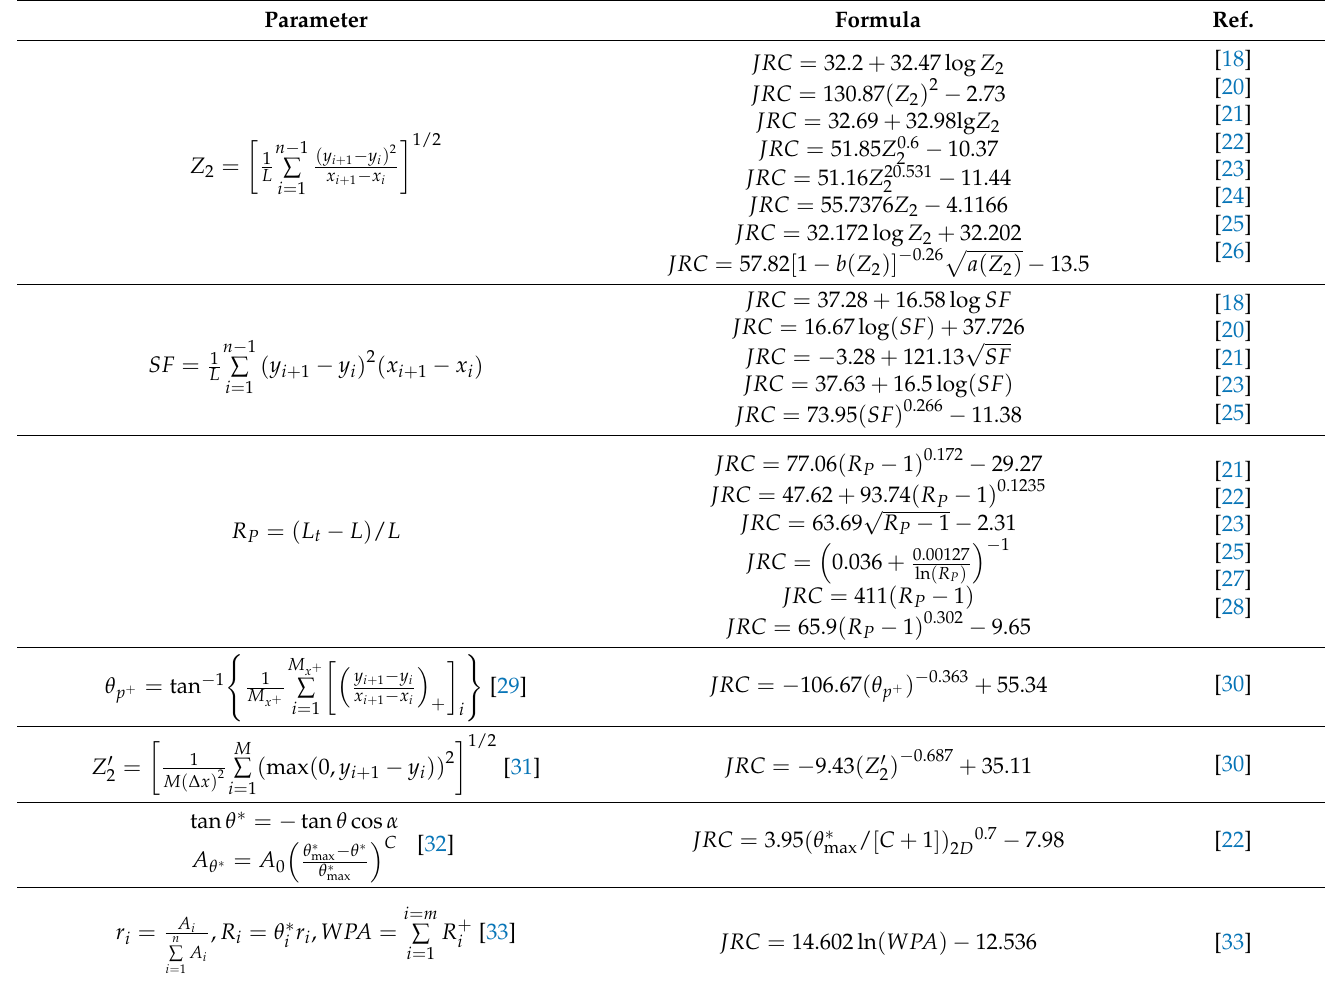
Table 1. The statistical parameter and characterization formula by single parameter. Parameter Formula